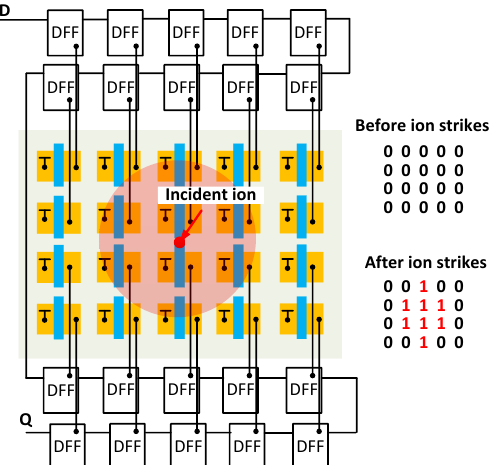
Figure 2. The layout schematic of a TAISAM circuit. The transistor array is placed in the center region and the flip-flops are placed beside the transistor array.